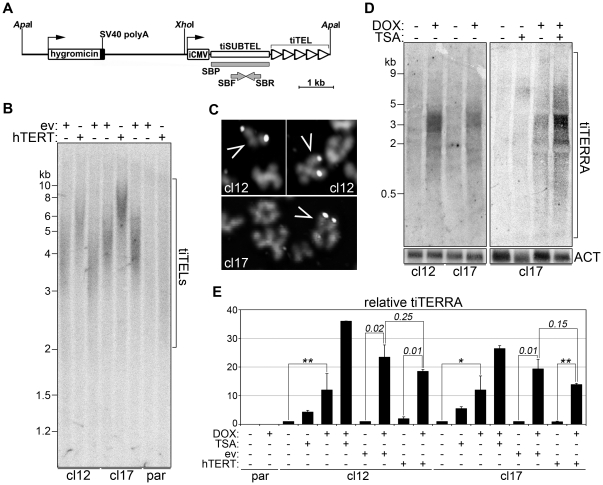
Generation and characterization of transcriptionally inducible telomeres (tiTELs).(A) Scheme of the tiTEL seeding vector. iCMV: inducible CMV promoter; SBF and SBR: oligonucleotides used in RT-PCR experiments; SBP: probe used in TRF, STELA and northern blot experiments. (B) tiTEL TRF analysis of genomic DNA prepared from clone 12 (cl12), clone 17 (cl17) and parental (par) cells infected with hTERT-expressing retroviruses or ev control retroviruses. DNA was hybridized using SBP probes. Marker molecular weights are on the left in kilobases. (C) Partial metaphases from cl12 and cl17 hybridized in situ to detect tiTELs (arrowheads). (D) Northern blot analysis of total RNA from cl12 and cl17 treated for 24 h with combinations of doxycycline (DOX) and trichostatin A (TSA) or left untreated. SBP probes were used to detect tiTERRA. The same membranes were stripped and re-probed to detect beta-actin transcripts (ACT) to control for loading. (E) qRT-PCR analysis of tiTERRA steady-levels in the indicated cell lines treated with different combinations of DOX and TSA or left untreated. For each cell line, values are expressed as fold increase over untreated samples. Bars and error bars are averages and standard deviations from 3 to 7 experiments. P values for relevant samples are indicated by numbers or by the asterisks (*: P<0.01; **: P<0.001).